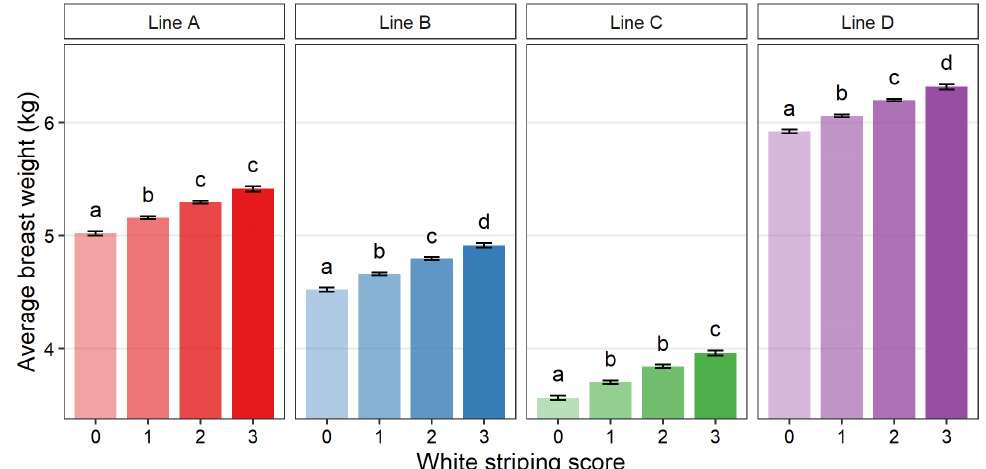
Figure 4. Least square means for breast weight (combined weight of Pectoralis major and minor muscles in kg) of purebred turkey toms for each white striping score (0–3) within each genetic line (A: n = 2830, B: n = 3677, C: n = 2031, D: n = 3652). Error bars show standard error. Means with different letters (a–d) within genetic line represent statistical significance ( p < 0.05) as determined by Tukey’s HSD test.